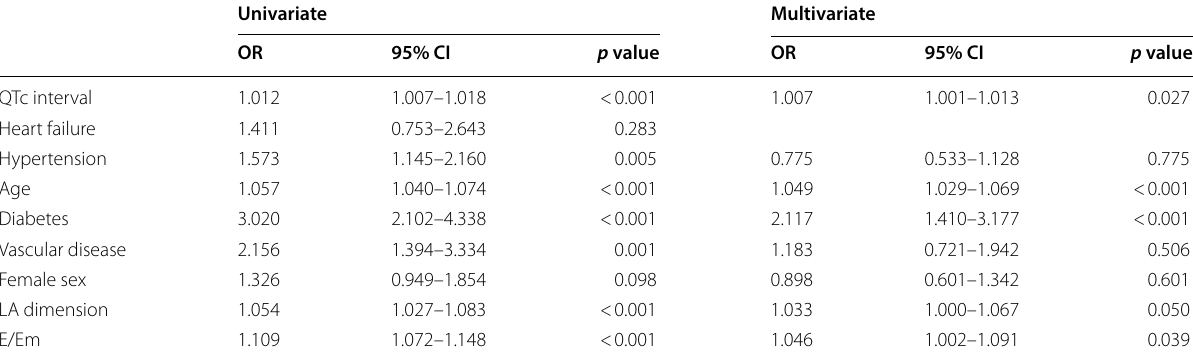
CI, confidence interval; E/Em, ratio of the early diastolic transmitral flow velocity and mitral annular velocity; OR, odds